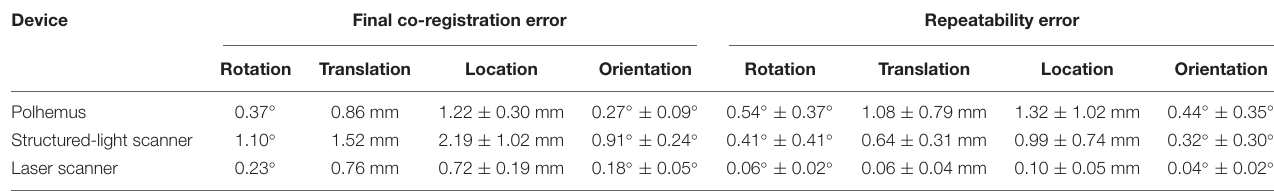
TABLE 3 | Final co-registration and the repeatability errors of each device in the reference phantom experiment.